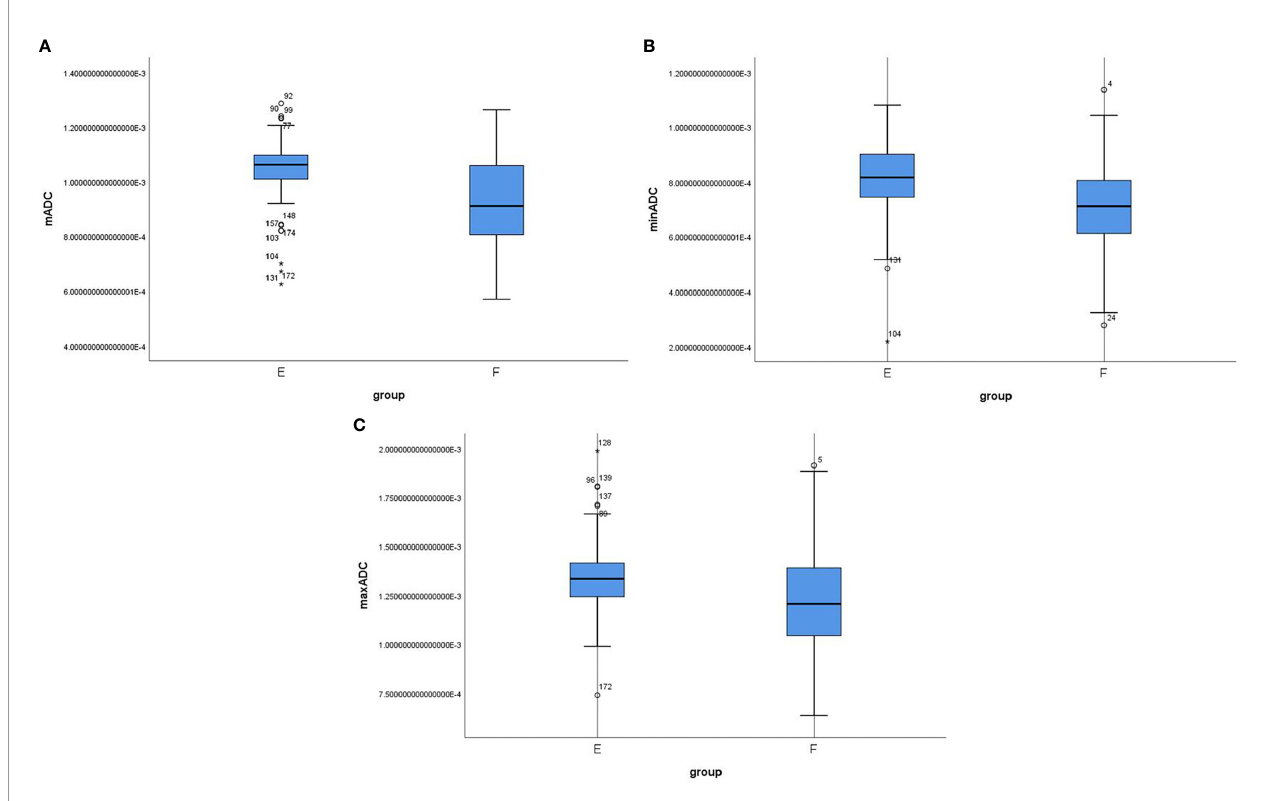
FIGURE 2 | Box-whisker plot showing the correlation among mADC (A) , minADC (B) and maxADC (C) values in Groups E and F Group E included stage IA G1/2 endometrioid carcinoma, and stage IB or G3 endometrioid carcinoma or nonendometrioid carcinoma were included in Group